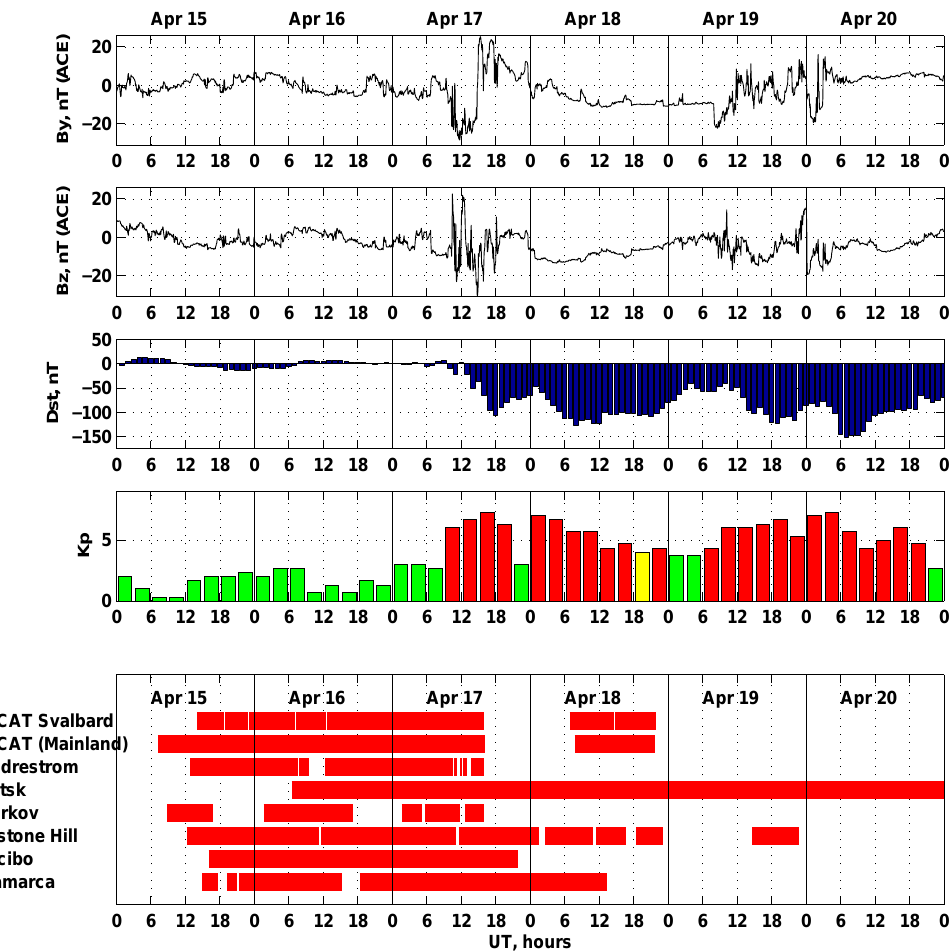
Fig. 2. The IMF B y and B z components (as measured by ACE satellite), the D st index, K p index and data coverage of incoherent scatter radars during April 2002